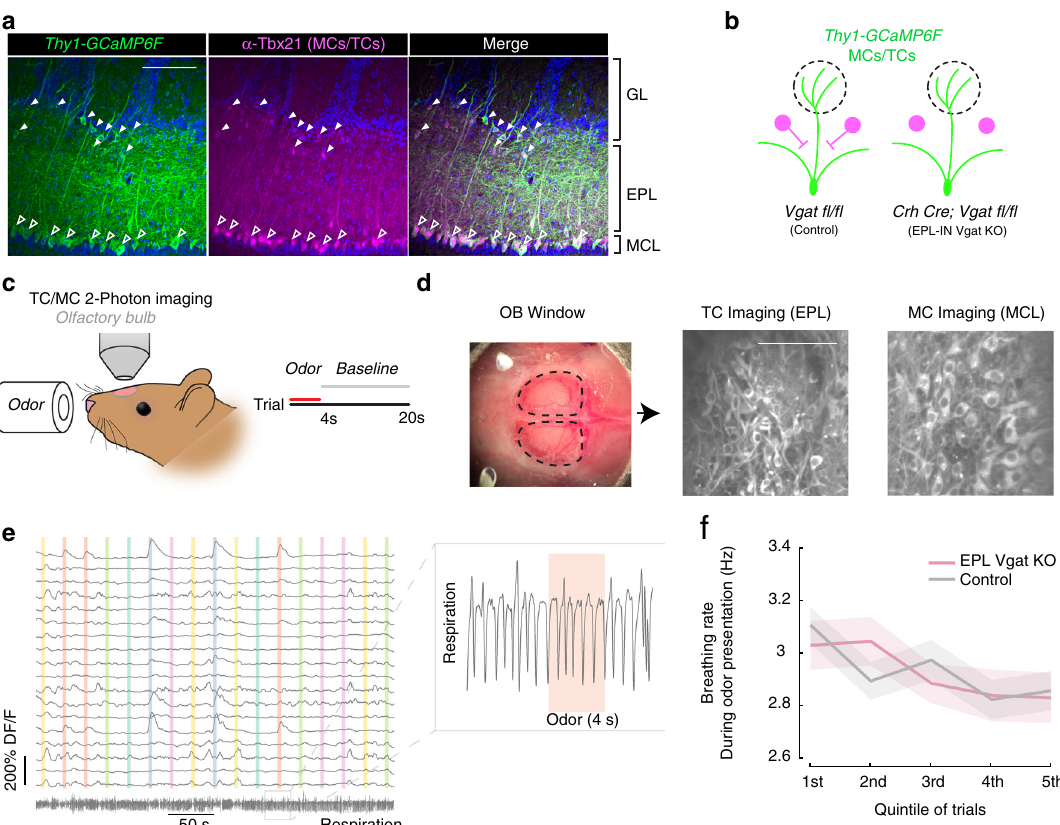
Fig. 4 Two-photon imaging of odor responses. a Thy1-GCaMP6F transgenic mice showing GCaMP6F positive MCs (hollow triangle) and TCs (solid triangle) (left) as identi fi ed by anti-TBX21 labeling (middle, right). b Thy1-GCaMP6F allele in control and EPL-IN Vgat knockout animals. c In vivo 2-photon imaging in awake, head- fi xed rodents. d Example cortical window for 2-photon experiment (left). Example GCaMP imaging of different depths for TCs (middle) and MCs (right). Scale bars, 100 μ m. e Example calcium traces from 18 TCs, with odor stimulation periods represented as colored bars. Scale bars represent 200% df/f. The respiration measured as temperature modulation is shown in the bottom trace. Insert shows a small segment of the respiration during one trial. f Average breathing rate (Hz) as a function of time in the experiment for all